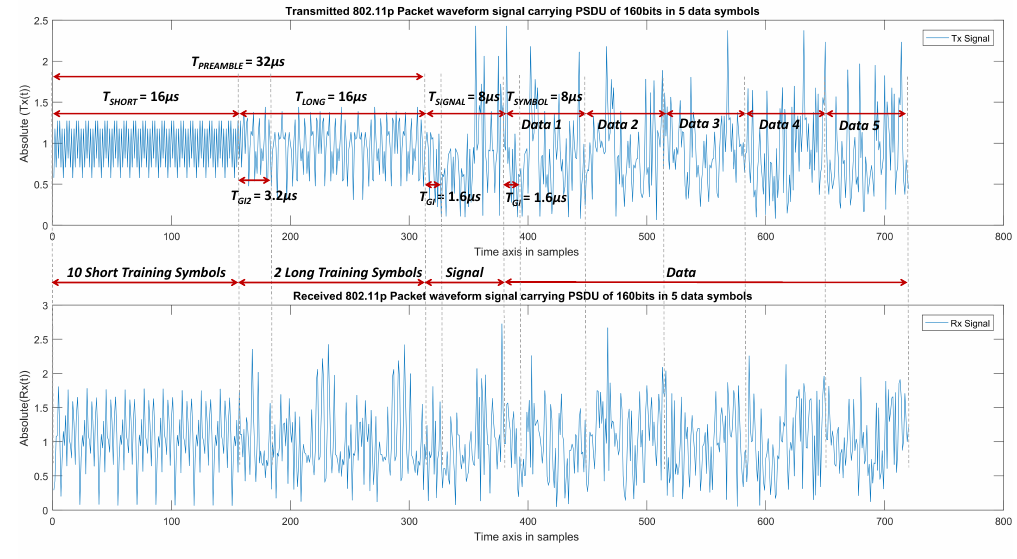
Figure 4. Transmitted and Received IEEE 802.11p